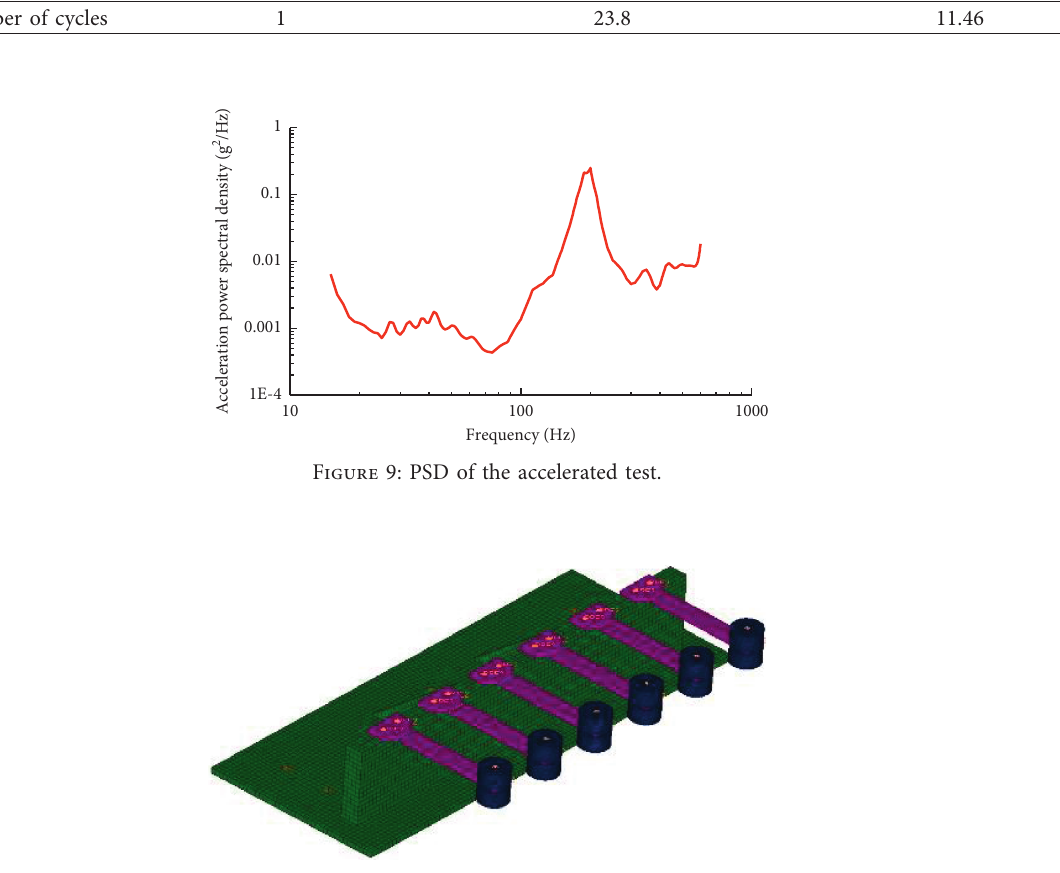
Figure 10: Finite-element model of the tooling and aluminum alloy notched specimens.